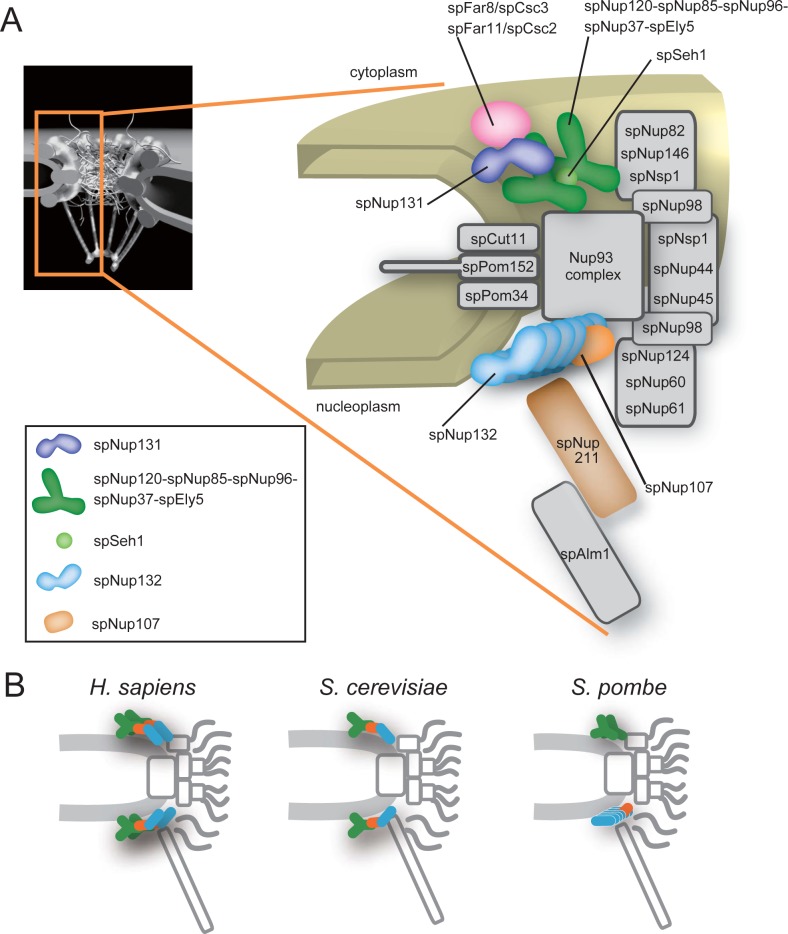
Model of the S. pombe NPC.(A) Positions of the S. pombe Nups. The numbers of the Nup107-160 subcomplex components were deduced based on the FM and biochemical analysis reported previously [29]: spNup131 (1 molecule, dark blue), the spNup120-spNup85-spNup96-spNup37-spEly5 complex (2 molecules each, dark green), spSeh1 (1 molecule, light green), spNup107 (1 molecule, orange), spNup132 (6 molecules, right blue). (B) Schematic drawings of the NPC structure in H. sapiens (left) [5] and S. cerevisiae (middle) [26] in comparison to that in S. pombe (right).